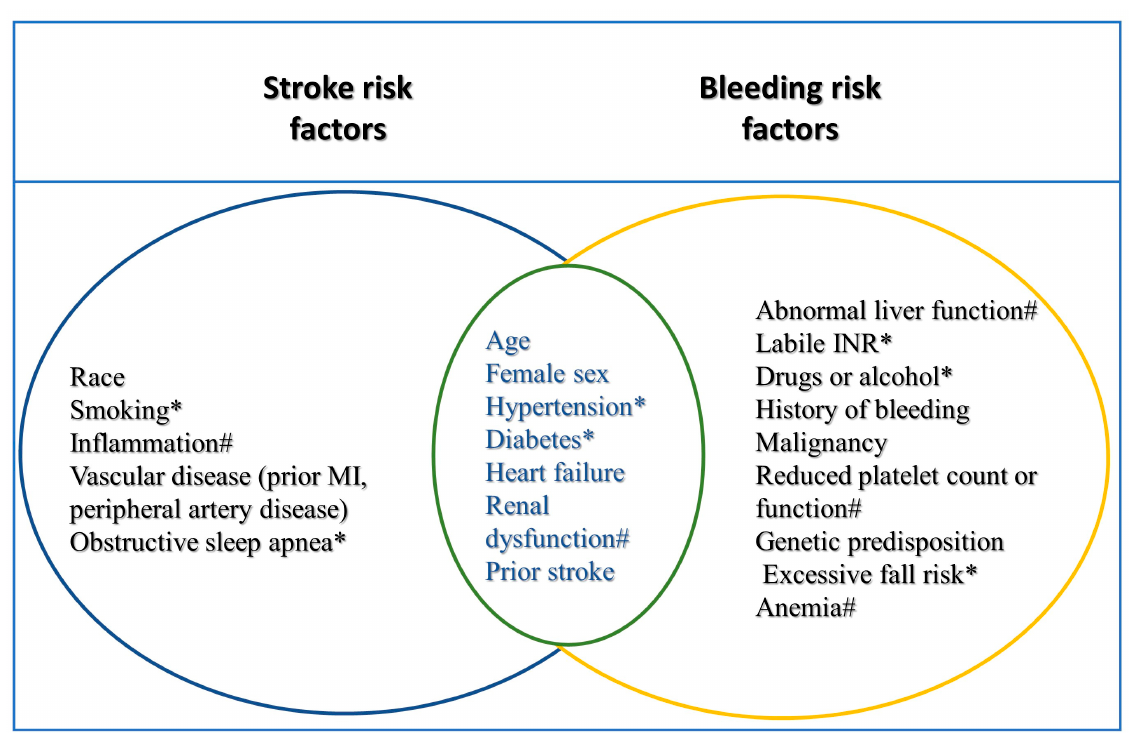
Figure 2. Risk factors for stroke, bleeding, and shared risk factors in patients with atrial fibrillation. *—indicates modi fi able bleeding risk factors. #—indicates potentially modi fi able bleeding risk factors. INR—International Normalized Ratio; MI—myocardial infarction.